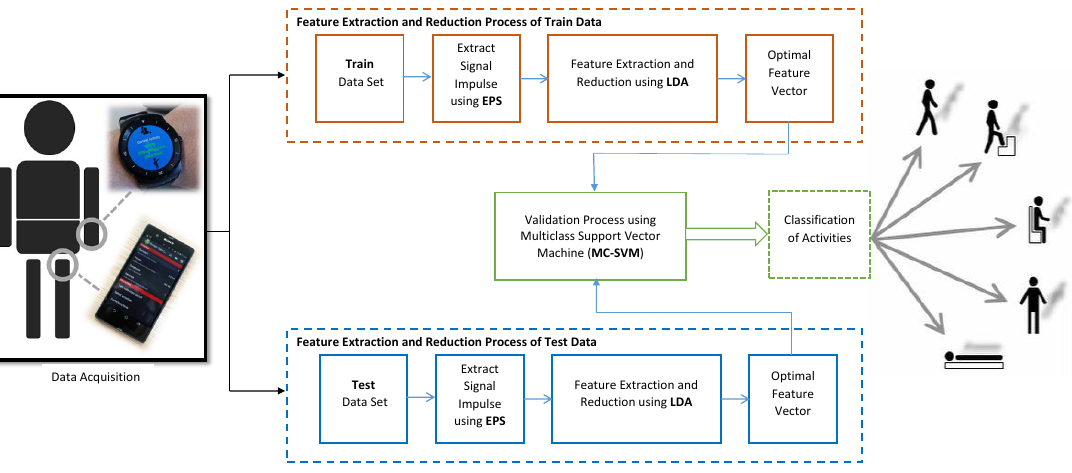
Figure 1. Working flow-diagram of the proposed